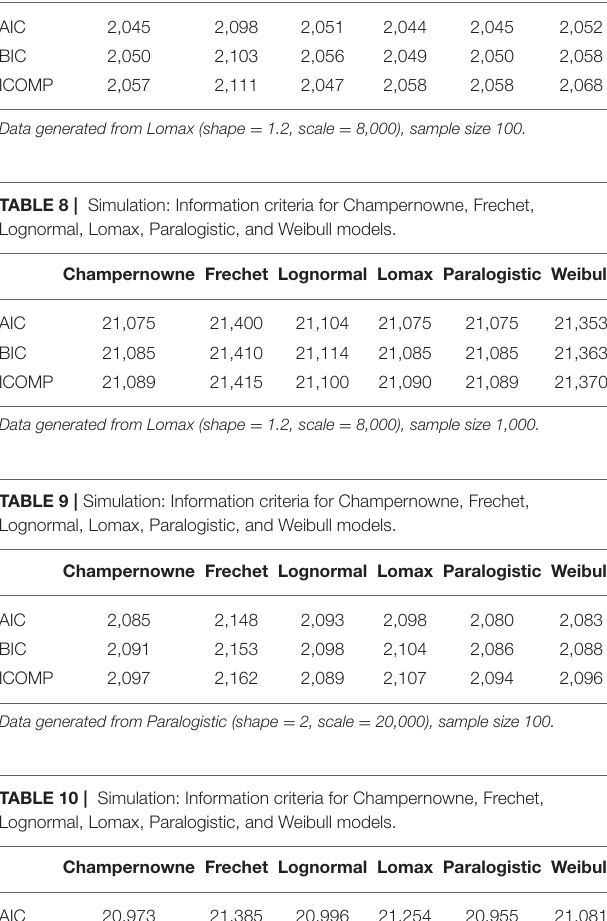
TABLE 2 | Simulation: Information criteria for Champernowne, Frechet, Lognormal, Lomax, Paralogistic, and Weibull models. Champernowne Frechet Lognormal Lomax Paralogistic Weibull